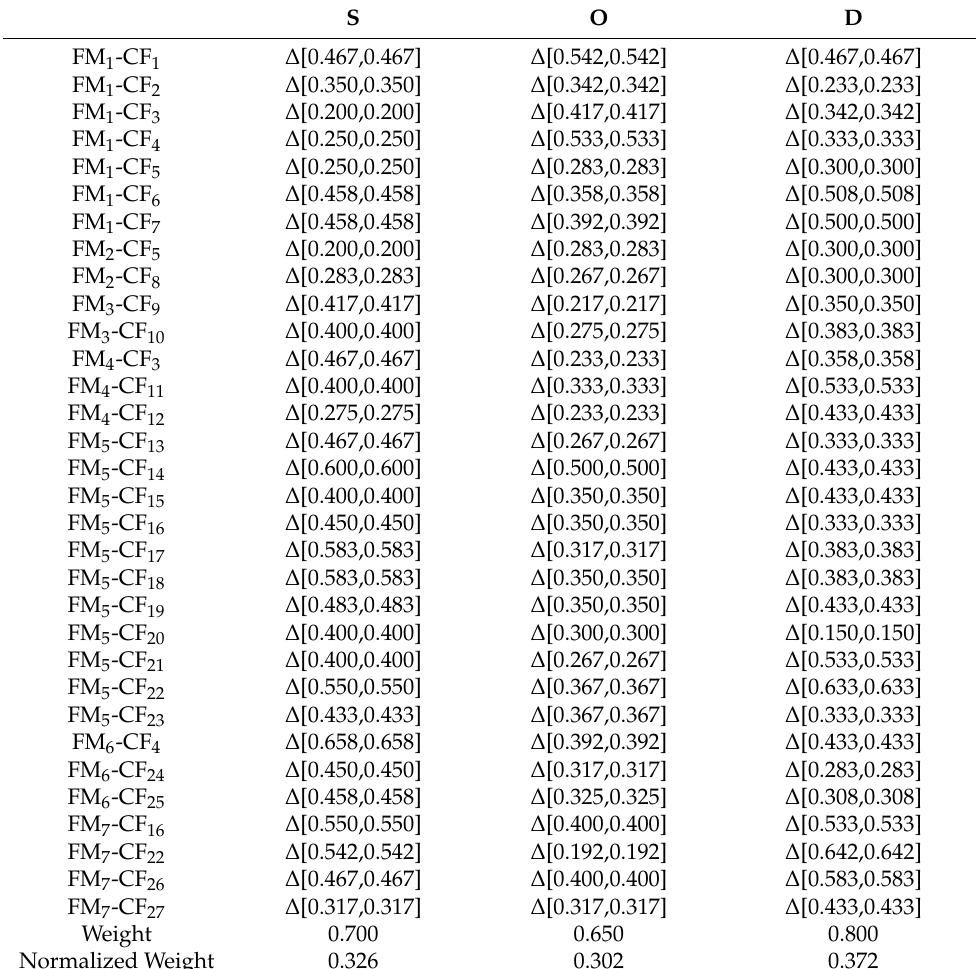
Table 7. Interval 2-tuple linguistic decision matrix (cid:101)